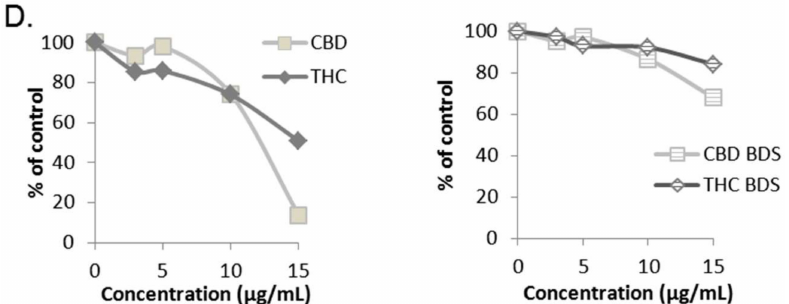
Figure 1. The influence of pure CBD/THC and cannabis extracts on lymphocyte activation. Proliferation of CFSE-stained, CD3-activated splenocytes from C57BL/6 ( A , C ) and Balb/c ( B ) mice was analyzed on day 4 after activation using flow cytometry analysis. ( A ) Summary of six independent experiments. When Comparing all treatments to control, the differences are significant starting from 3 µ g/mL. The differences between THC/CBD and THC BDS/CBD BDS are significant starting from 5 µ g/mL. ( B ) Summary of three independent experiments. When Comparing all treatments to control, THC to CBD and THC BDS to CBD BDS, significant differences were observed starting from 5 µ g/mL. ( C ) Flow cytometry analysis of activated C57BL/6 splenocytes stained with anti-CD4 and anti-CD8 antibodies. Data is summarized from six independent experiments for pure cannabinoids and four independent experiments for BDS. Results are expressed as mean + SEM. p Value as compared to the activated control cells *, <0.05; **, <0.001; ***, <0.0001. ( D ) C57BL/6 splenocytes were activated for 4 h, stained with anti-CD69 antibodies and analyzed using flow cytometry. Data is summarized from three independent experiments. The differences of all treatments as compared to control are significant at 15 µ g/mL, act: activated splenocytes, THC: D9 tetrahydrocannabinol, CBD: cannabidiol, BDS: Botanical Drug